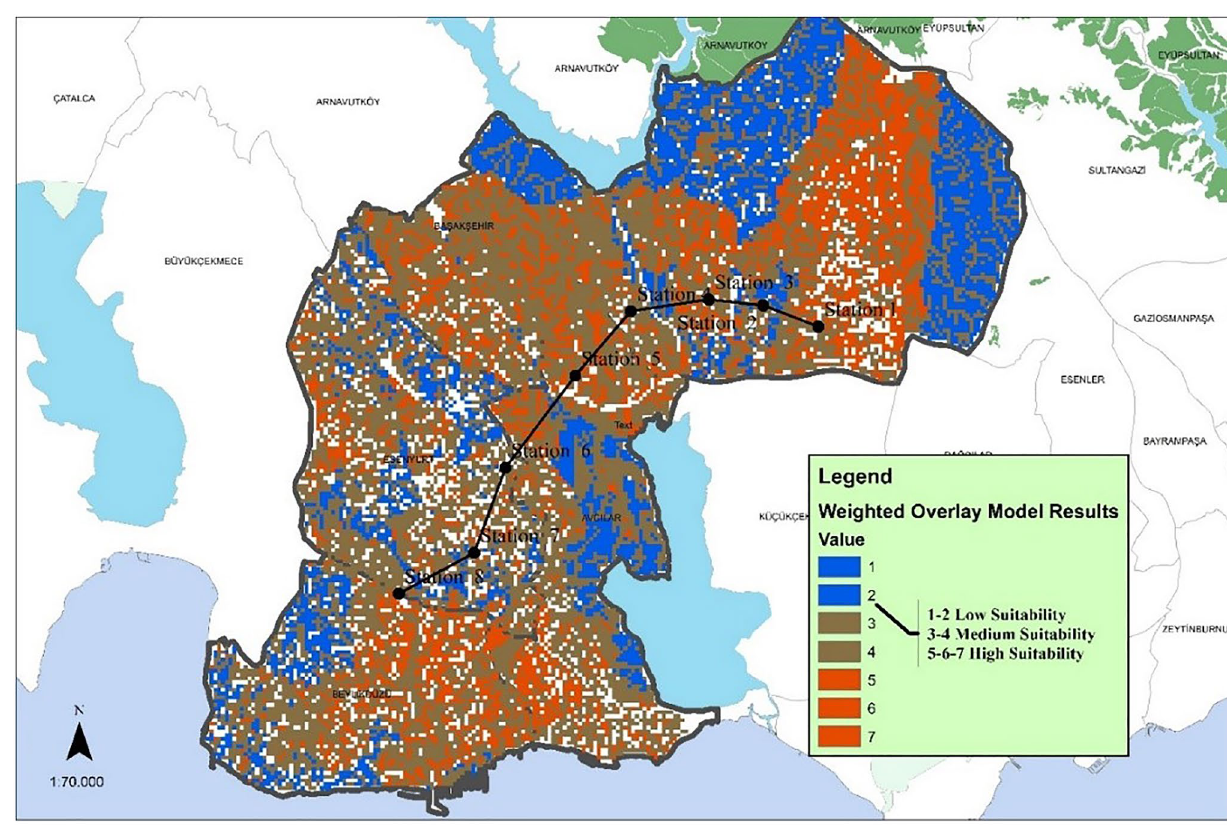
Fig. 6 Weighted overlay analysis map (illustrated by